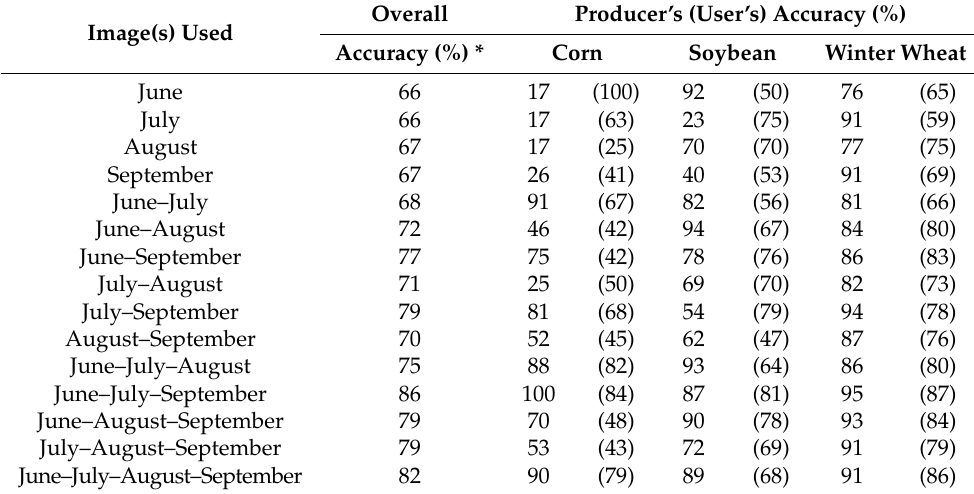
Table 8. Hyperion Naive Bayes Accuracies. Classification accuracies for Naive Bayes separating three leading world crops (corn, soybean, and winter wheat) using 15 Hyperion narrowbands. Analysis was conducted across 3 years, for 4 months throughout each growing season when available; these accuracies are averages across those 3 years.